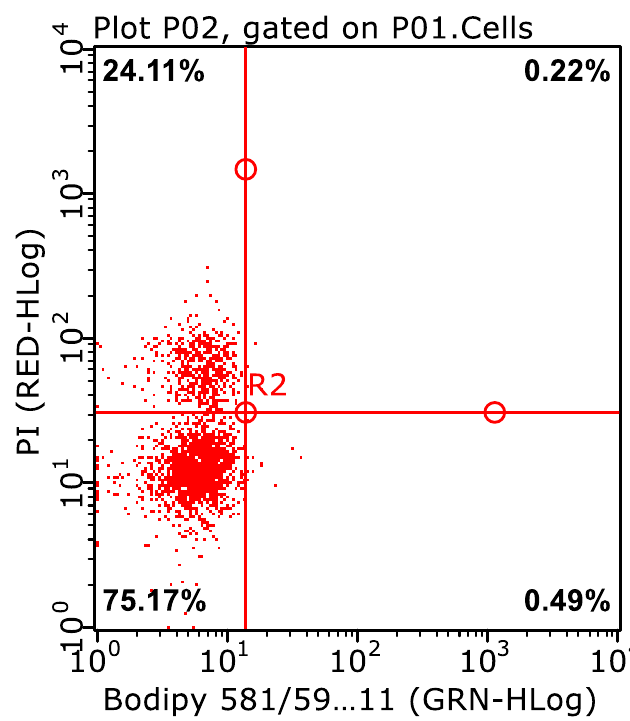
Figure 8. An example of a dot plot with live spermatozoa without lipid peroxidation in the Experi- mental group in the lower left quadrant (75.17%): PI-/BODIPY- (PI, propidium iodide; BODIPY, flu- orescent membrane probe).